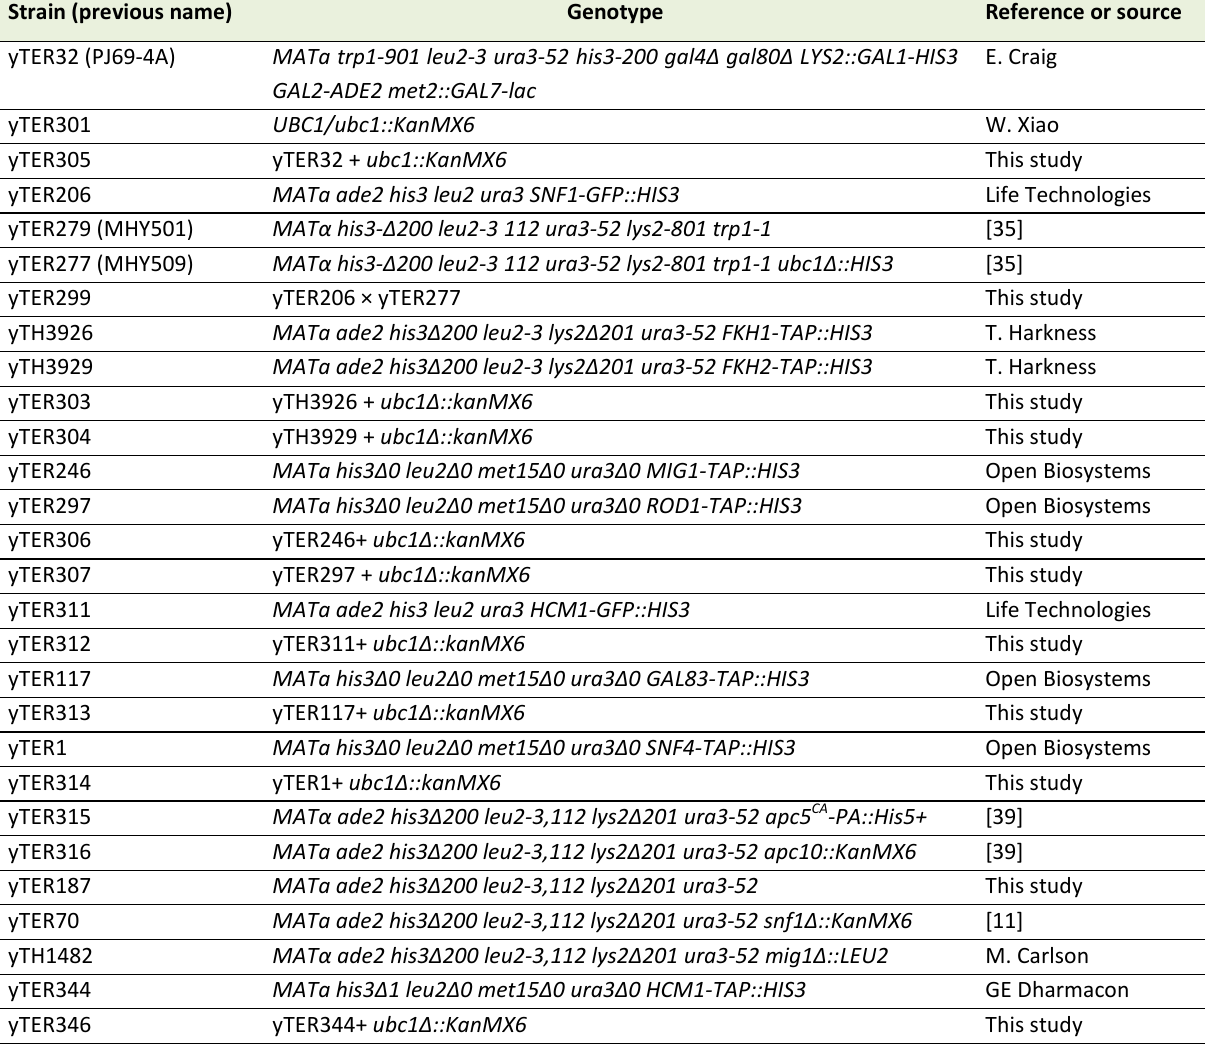
Table 1. Saccharomyces cerevisiae strains used in this